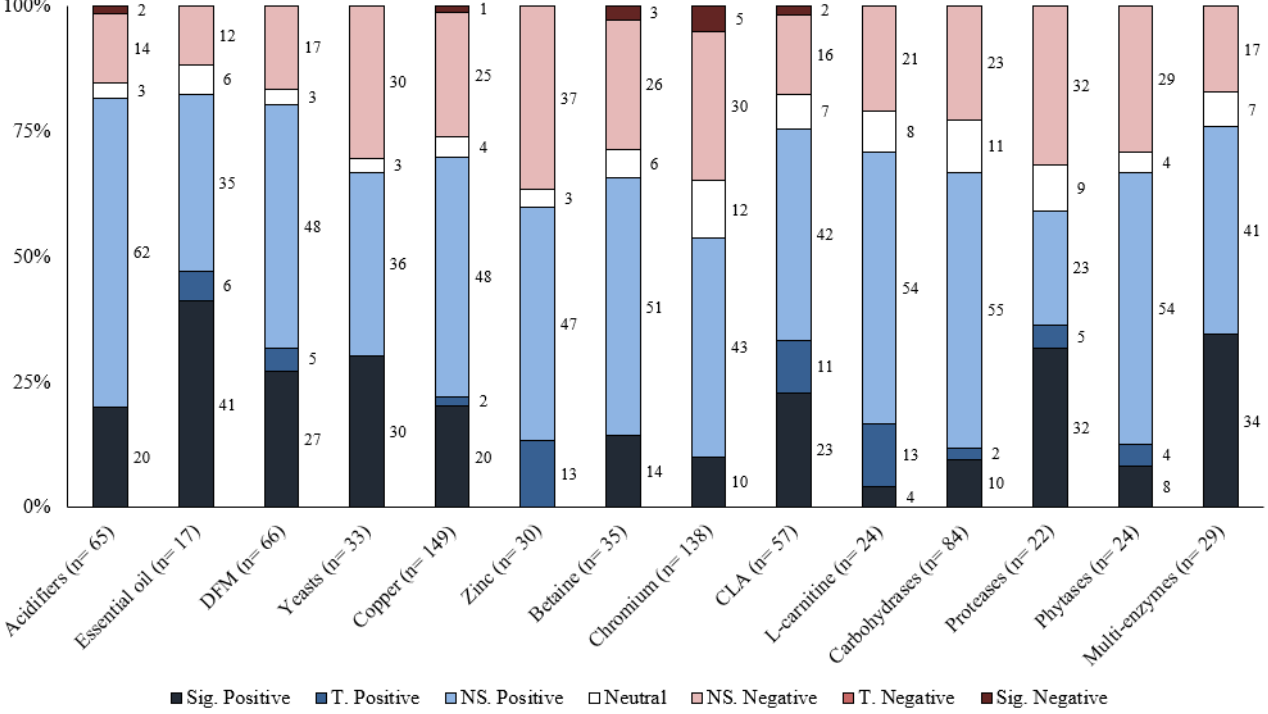
Figure 2. The distribution of results for various feed additives on G:F by significance level and direction. The comparison was significant (Sig.) if p ≤ 0.05, had a tendency (T.) if 0.05 < p ≤ 0.10, and was non-significant (NS.) if p > 0.10.